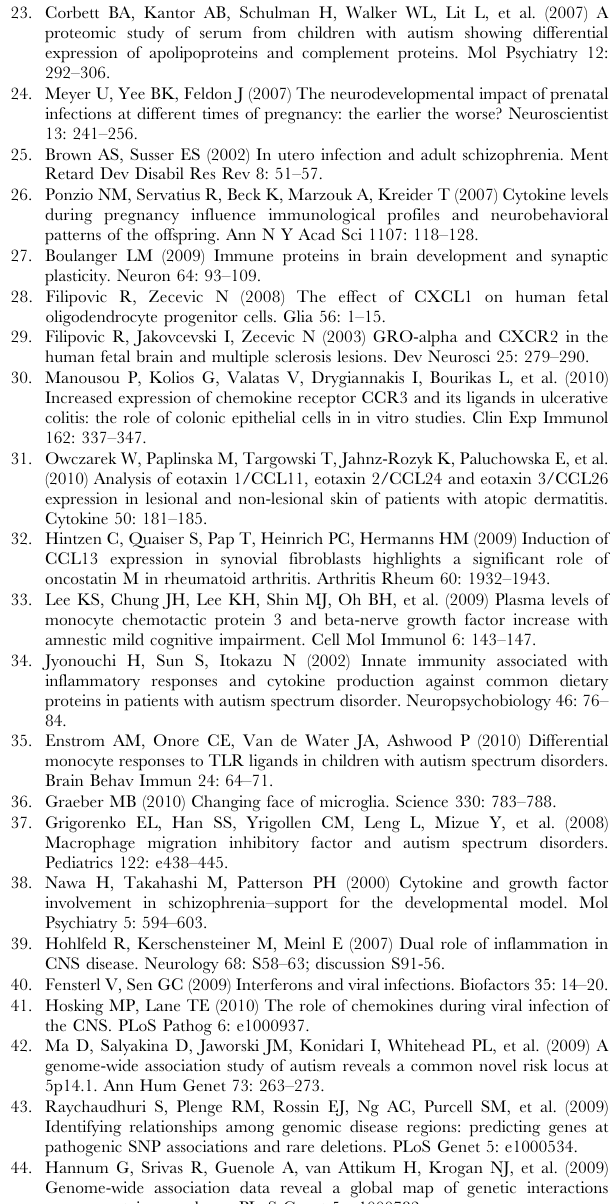
Table S3 Results of LoGS analysis using only genes that were both within 50% recombination distance of the autism loci AND overlapped with CNV’s. V = enrichment score. Table S4 Genes in the c6 and c34 gene sets under the LoGS analysis. Table S5 Top Enrichment themes of the c6 and c34 gene sets using EASE. Table S6 LoGS was rerun with different sized windows (forty percent, thirty percent, twenty percent, ten percent, and 5 percent recombination units). V =enrichment score.